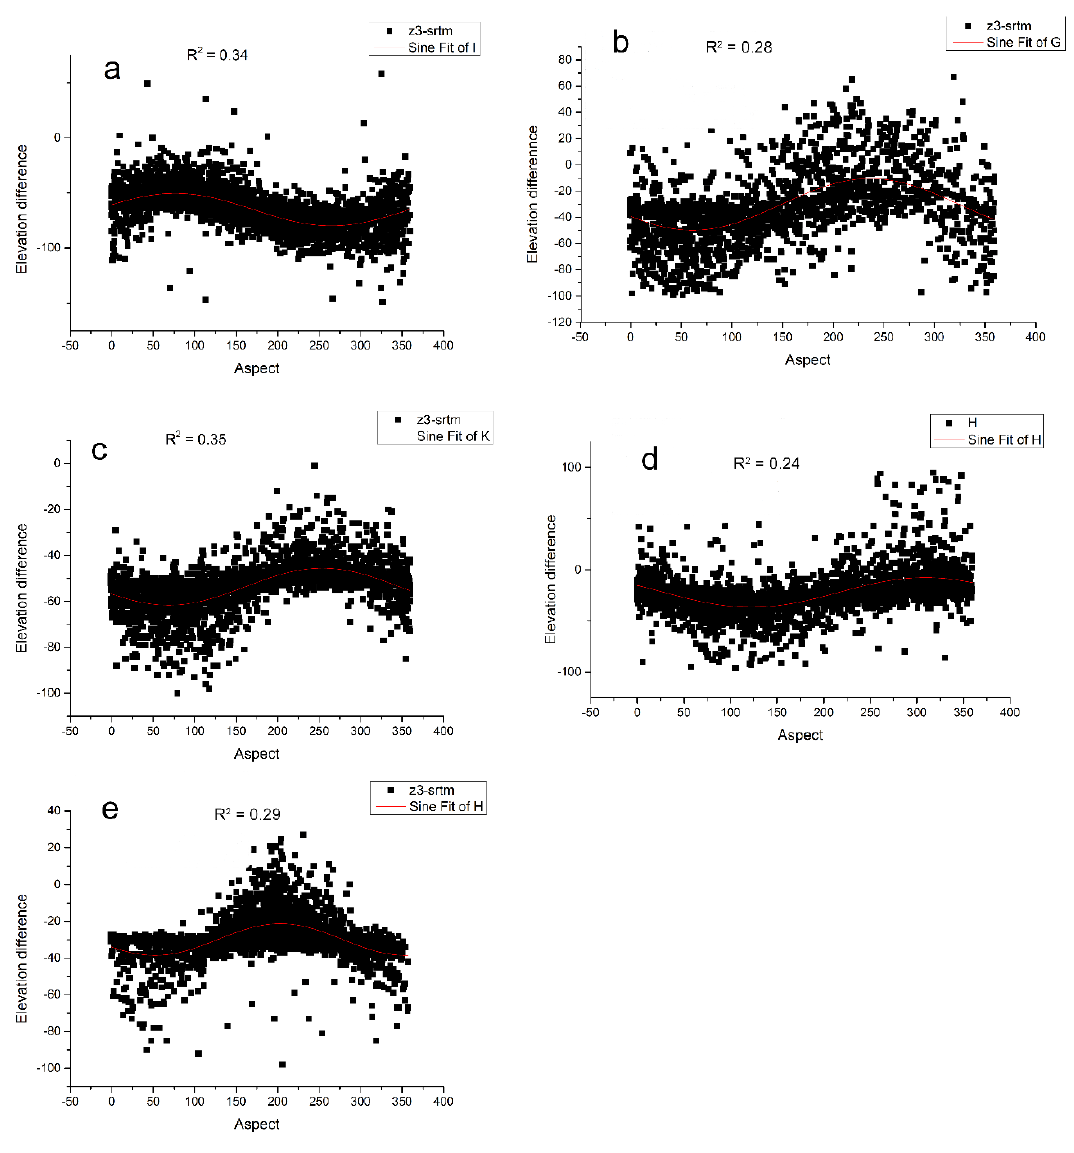
Figure 2. The sinusoidal relationship between the elevation difference between ZY-3 digital elevation model (DEM) and Shuttle Radar Topography Mission (SRTM) DEM and aspects in ( a ) sub-region a; ( b ) sub-region b; ( c ) sub-region c; ( d ) sub-region d; ( e ) sub-region e of Upper Reach of Shule River Basin